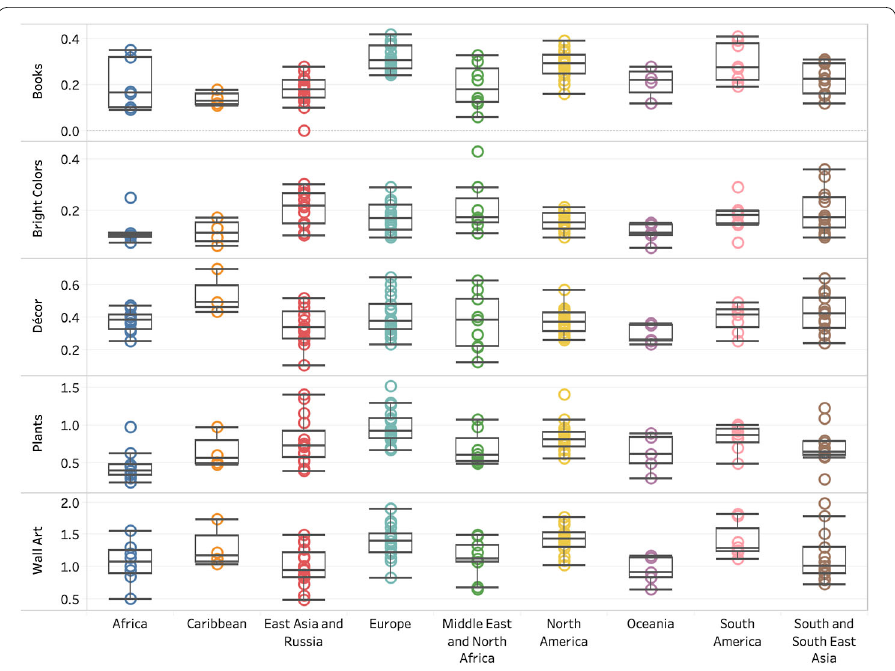
Figure 4 Regional variation in ornamentation and color prevalence. Each city is represented as one circle and classified by region to depict rates of interior various design elements. In summary, Europe and North